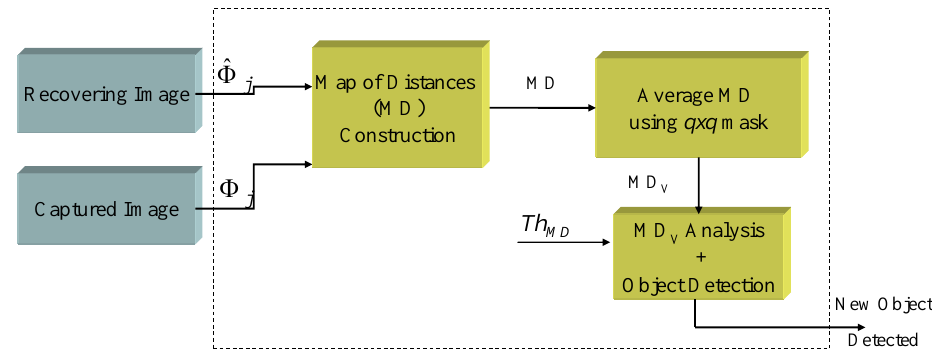
Figure 5. Proposal for the system consisting of the construction of the MD, detection of new objects and the updating of the background